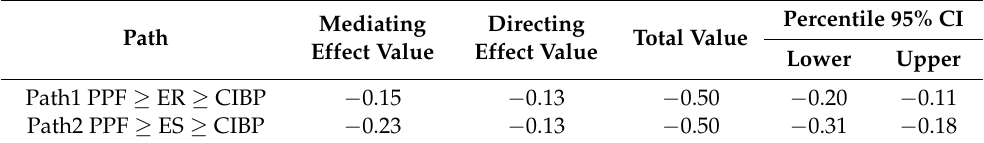
supported. Table 5. Mediation analysis of internalizing behavior Table 5. Mediation analysis of internalizing behavior problems.